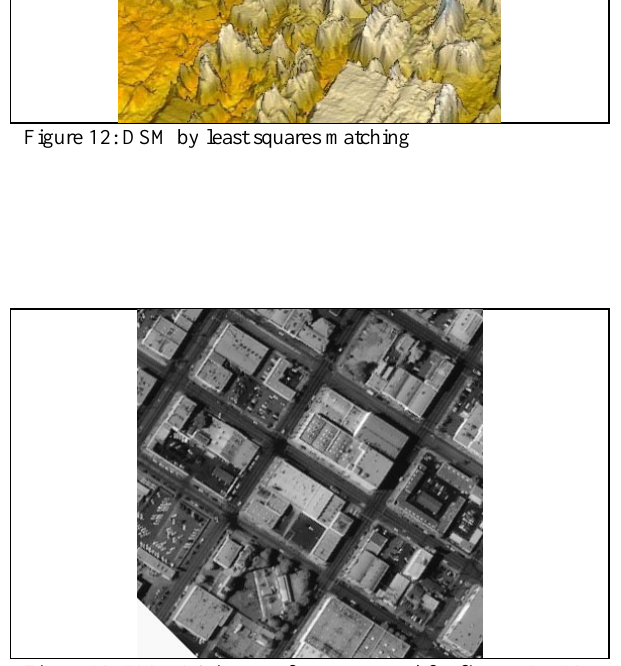
Figure 13: IKONOS image of test area used for figures 9 – 12